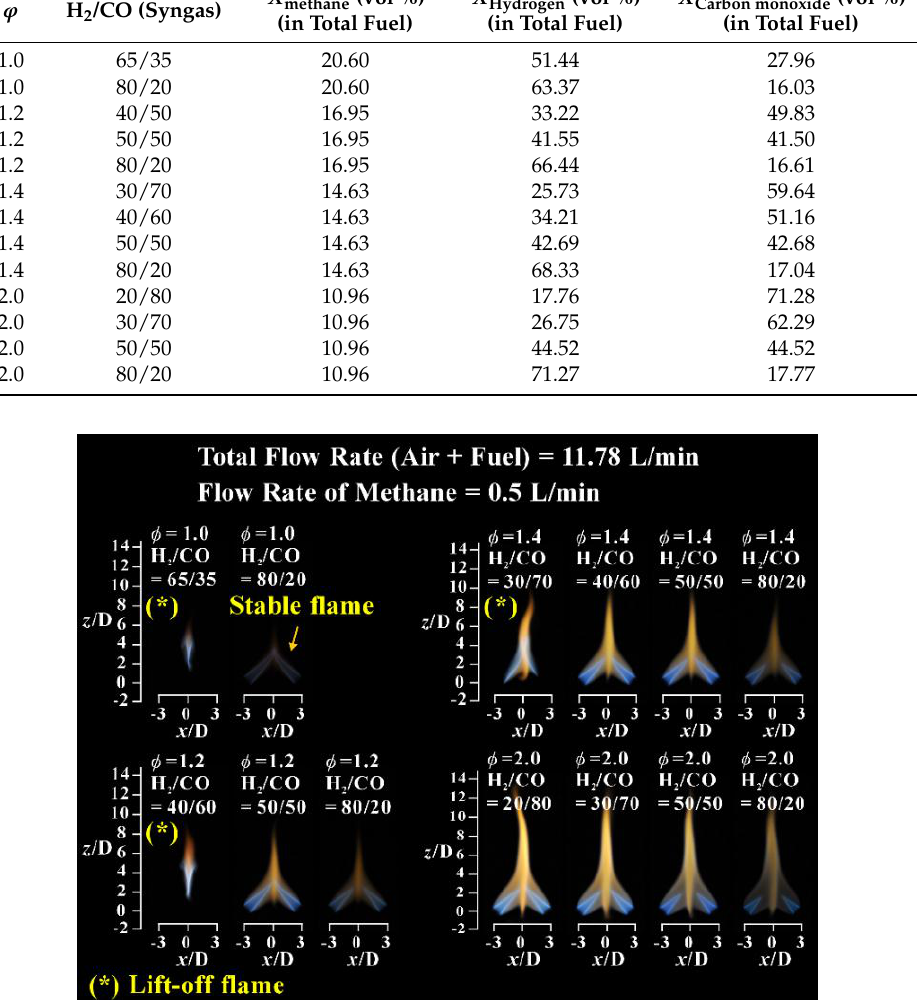
Table 3. Volume concentration of each fuel in the entire fuel mixture. Figure 2. Operating range of a CH 4 /syngas/air premixed impinging flame at φ = 0.8 to 2.0 with a constant total volume flow rate Q total = 11.78 L/min and a constant methane volume flow rate Q methane = 0.5 L/min.